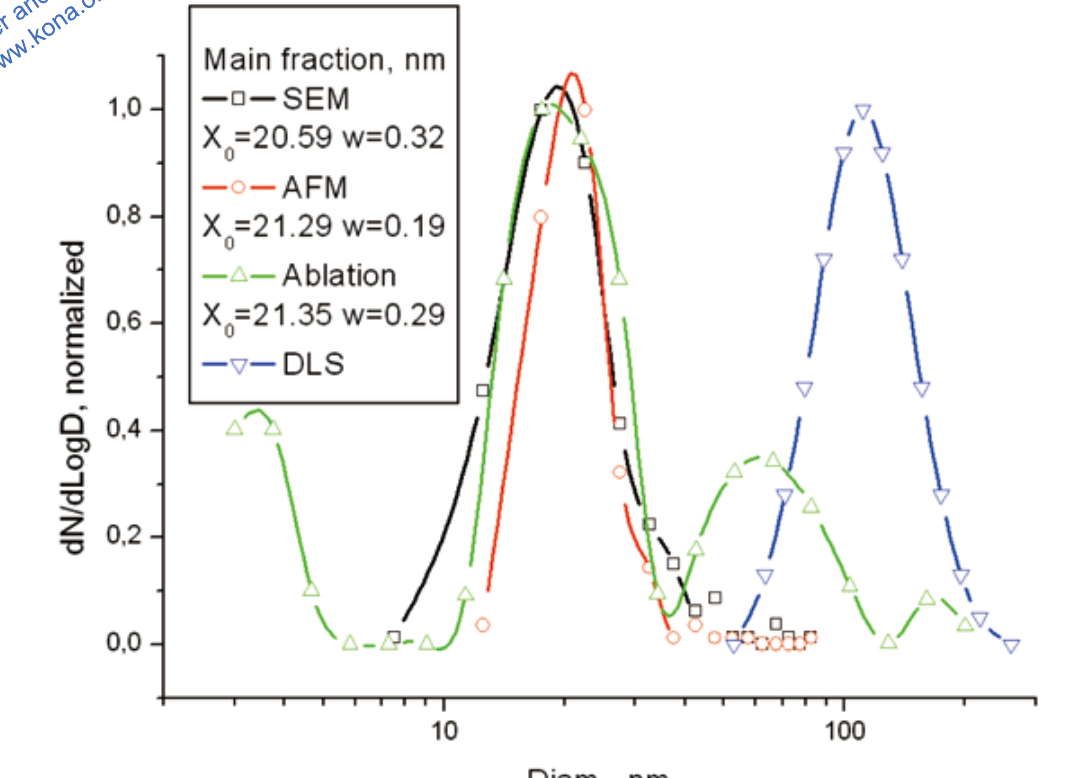
powder particles registered by scanning electron microscopy (SEM), atomic force mi- Fig. 4 Size distributions of SiO 2 croscopy (AFM), dynamic light scattering (DLS) and aerosol products of submillimeter laser ablation